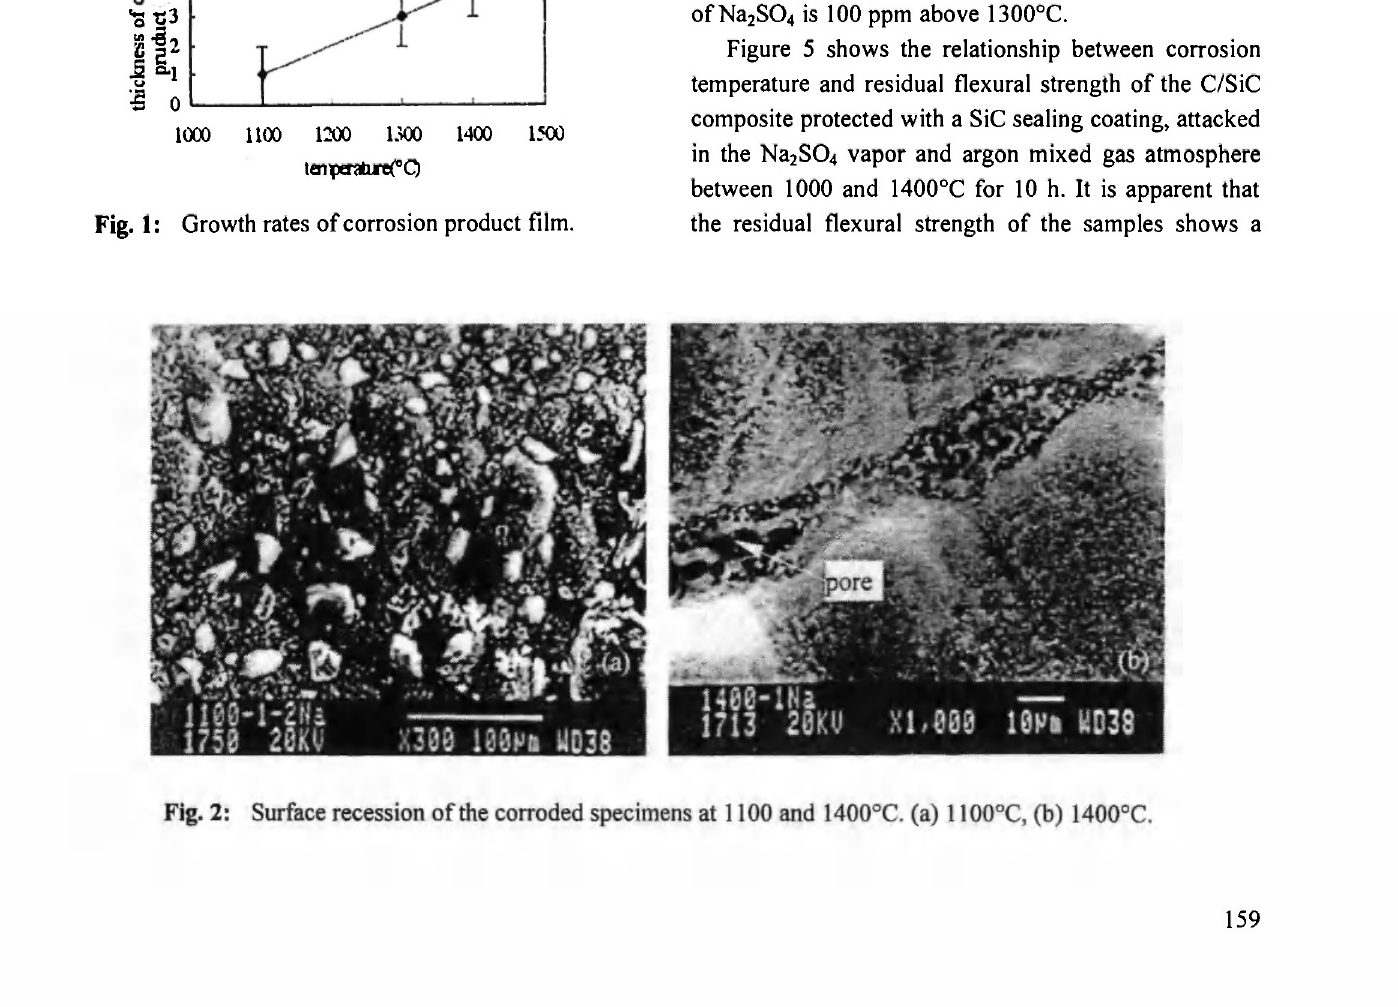
Fig. 1 : Growth rates of corrosion product